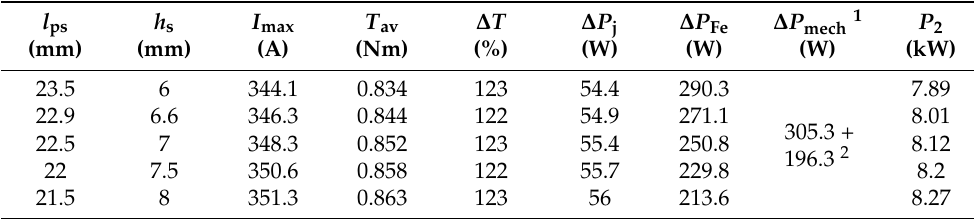
Table 6. Results of the analysis of the length of the stator poles.